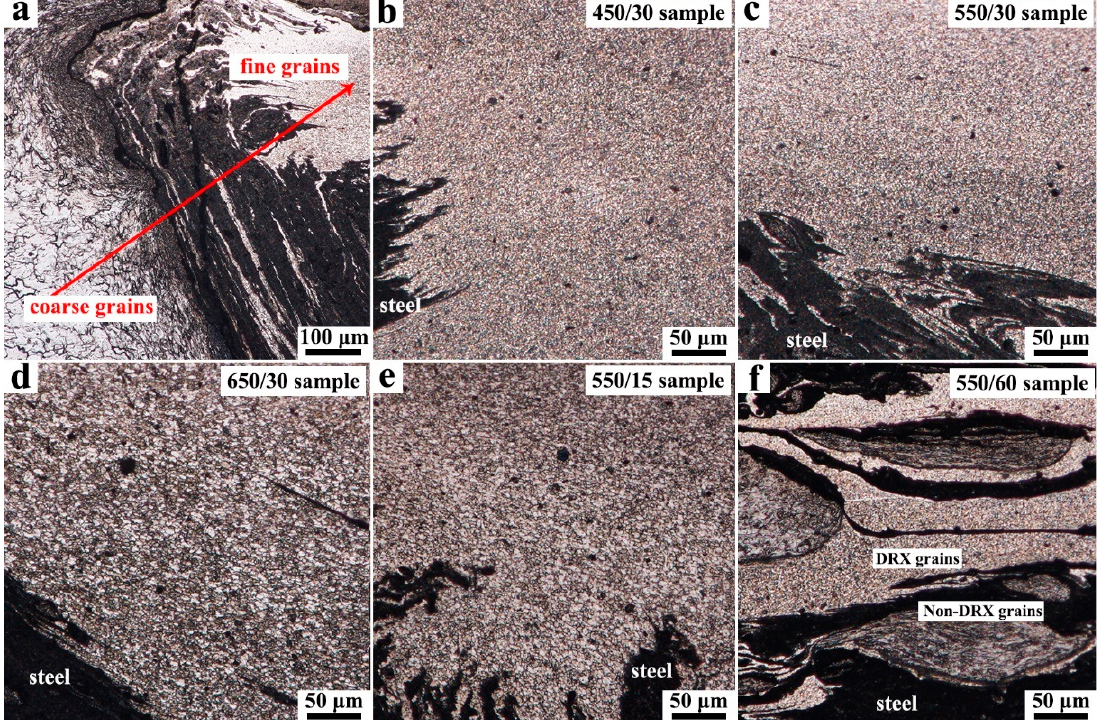
Figure 8. ( a ) The evolution of grain from BM to NZ, the grains in the NZs of the ( b ) 450/30, ( c ) 550/30, ( d ) 650/30, ( e ) 550/15, and ( f ) 550/60 samples.